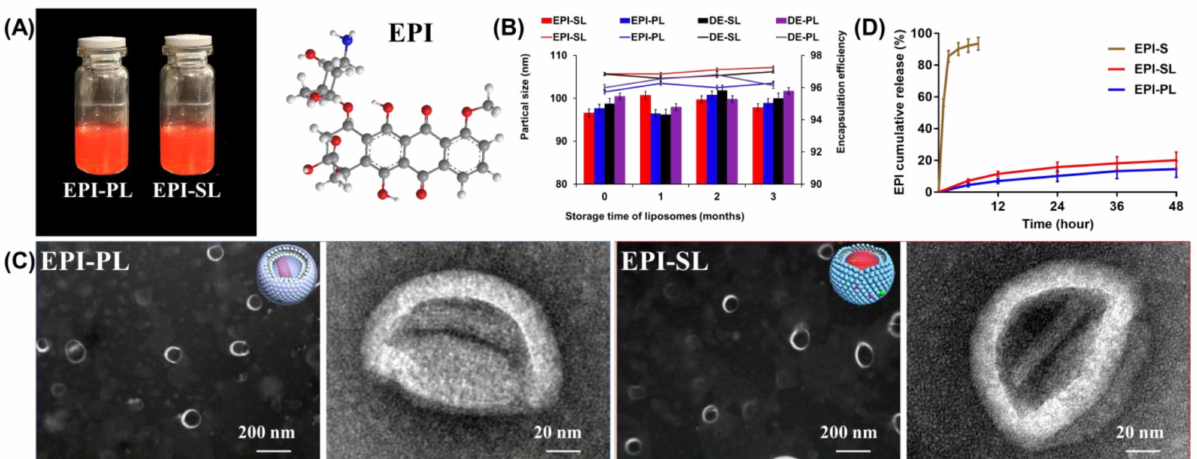
Figure 2. ( A ) The placement stability and appearance of the liposomes. Simulation of the interaction with SO 42+ and EPI. ( B ) The changes of EE% and particle size after three months, n = 6, (curve: particle size, histogram: EE%). ( C ) Phosphotungstic acid negative stain image of EPI-SL and EPI-PL. ( D ) EPI cumulation release of EPI-SL, EPI-PL, and EPI-solution, n = 3.